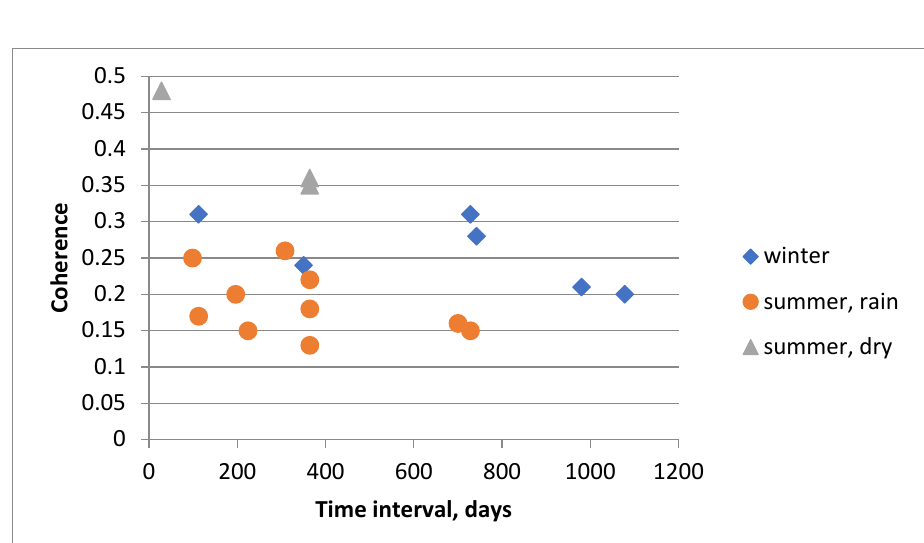
Figure 9. ALOS-2 interferometric coherence.